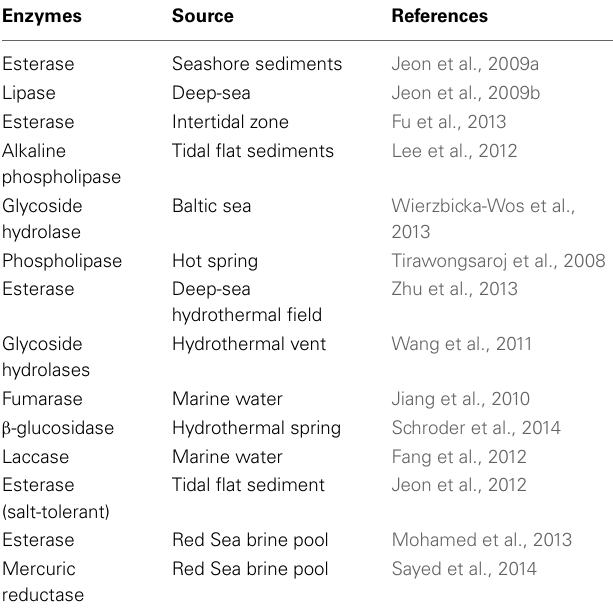
Table 1 | Extremozymes through marine metagenomic